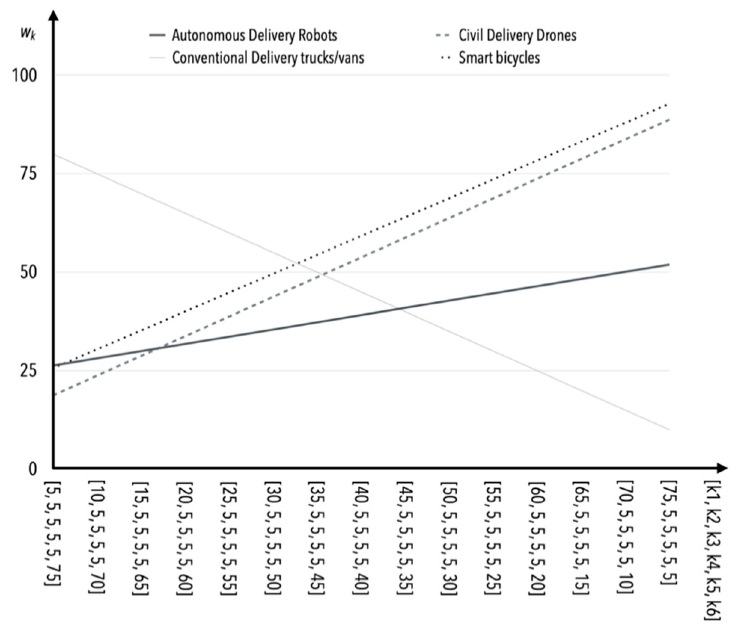
Figure 2. The influence of weight value changes for criterion K 1 on criteria K 2 –K 5 (in the case of S1).